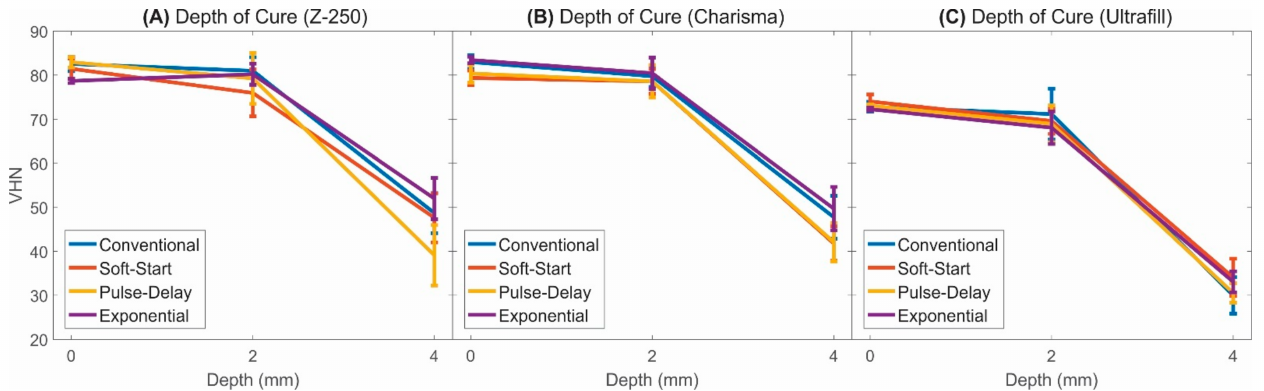
Figure 5. Hardness as a function of depth for the composites after the curing process: ( A ) Z-250; ( B ) Charisma and ( C ) Ultrafill.